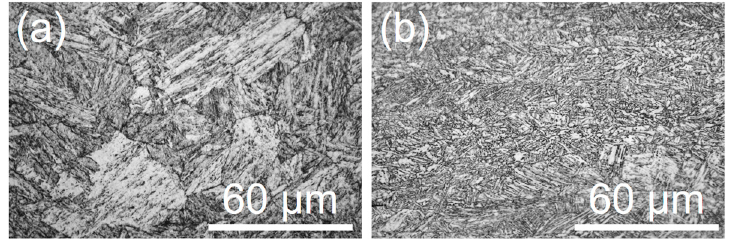
Figure 1. The optical metallography images showing the as-quenched microstructure in ( a ) S690Q steel and ( b ) NiCu steel.